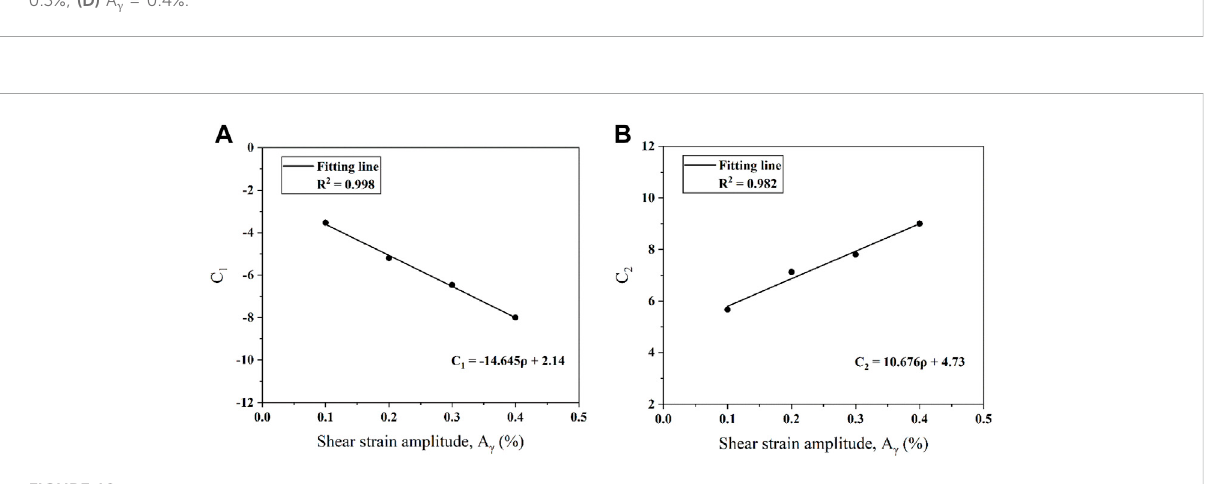
FIGURE 10 In fl uence of shear strain amplitude on the fi tting parameters: (A) C 1 ; (B) C 2